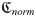
The distribution of Cnorm on all trees in TreeBASE (black line) and its estimated theoretical distribution under the α-γ-model with α = 0.7 and γ = 0.4 (blue line).